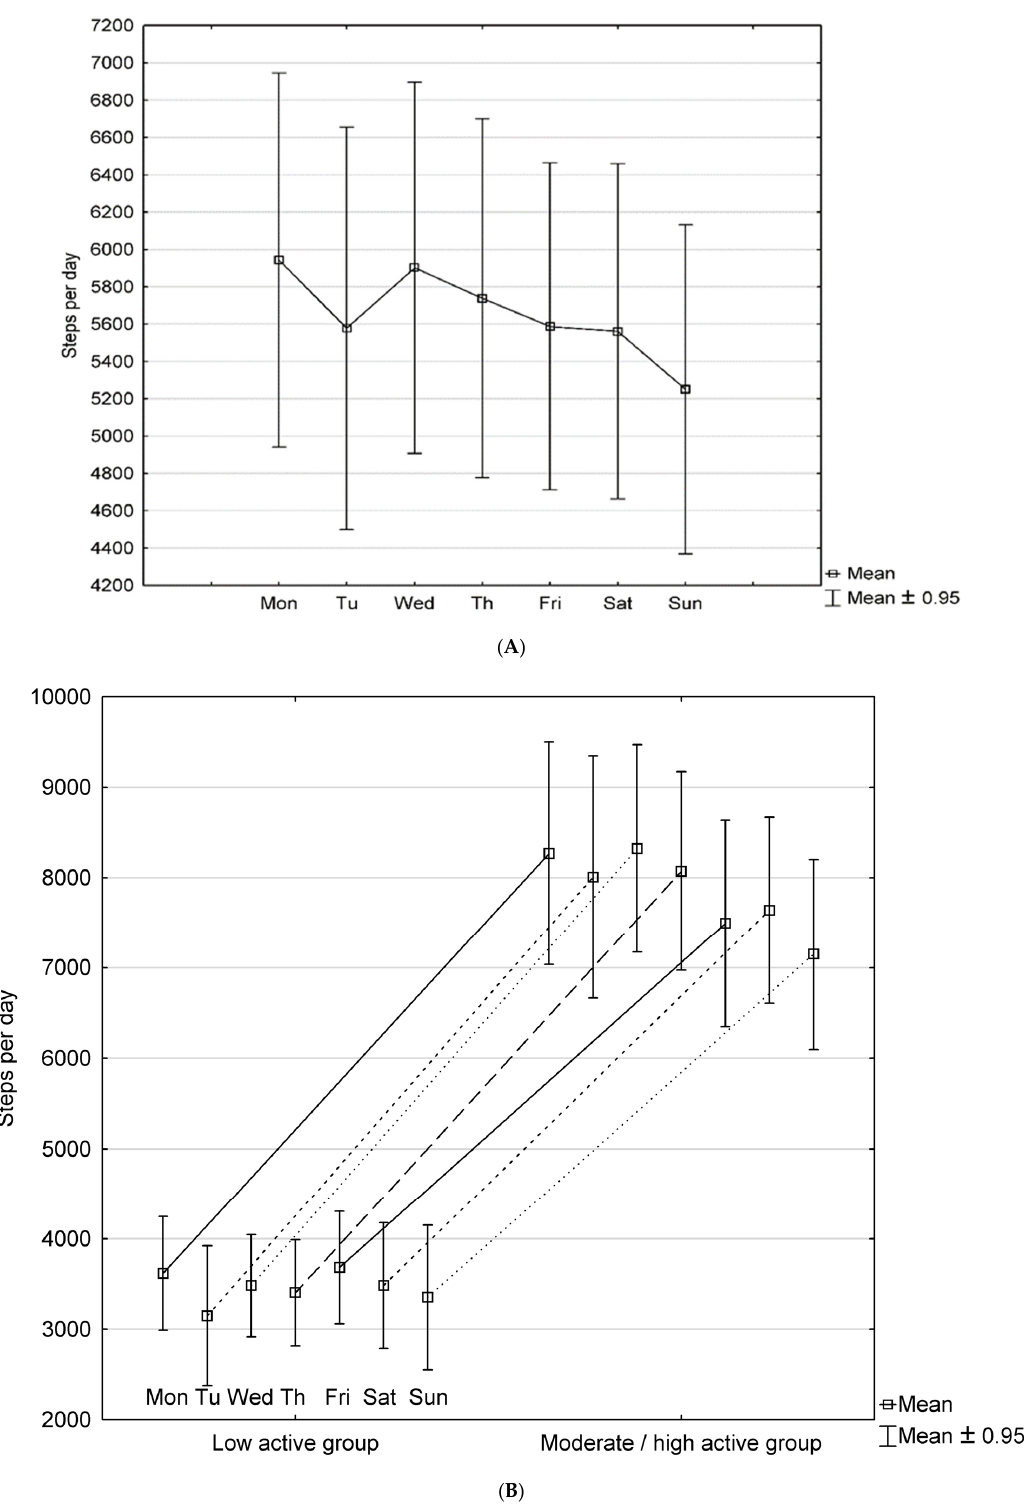
Figure 1. ( A ) Daily steps count for the whole group of PAH patients—variability in mean steps/day across the week. ( B ) Daily steps count for the low-activity and moderate–high-activity subgroups of PAH patients—variability in mean steps/day across the